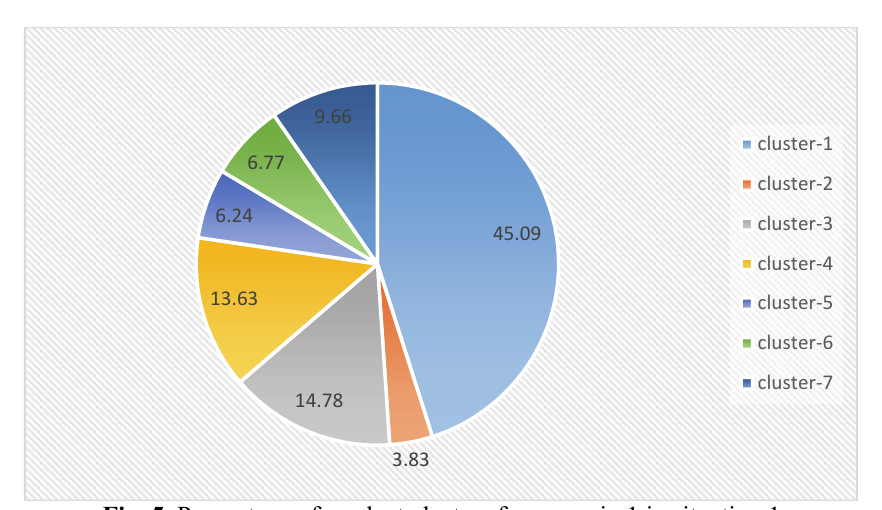
Fig. 5. Percentage of product clusters for scenario 1 in situation 1